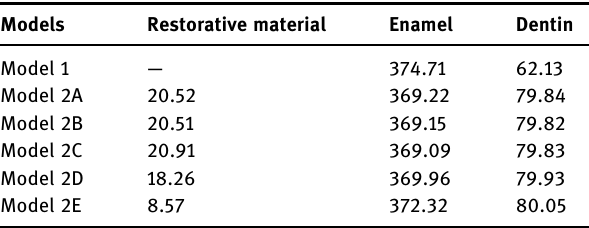
Table 3: Maximum Von Mises stress values ( MPa ) in models